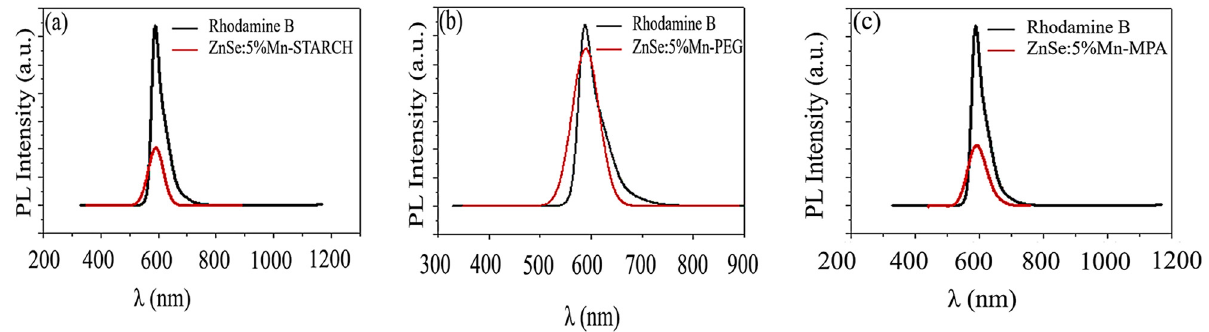
Figure 6: The PLQY compared to reference photoluminescence of ZnSe:5% Mn capped with MPA, PEG, and starch